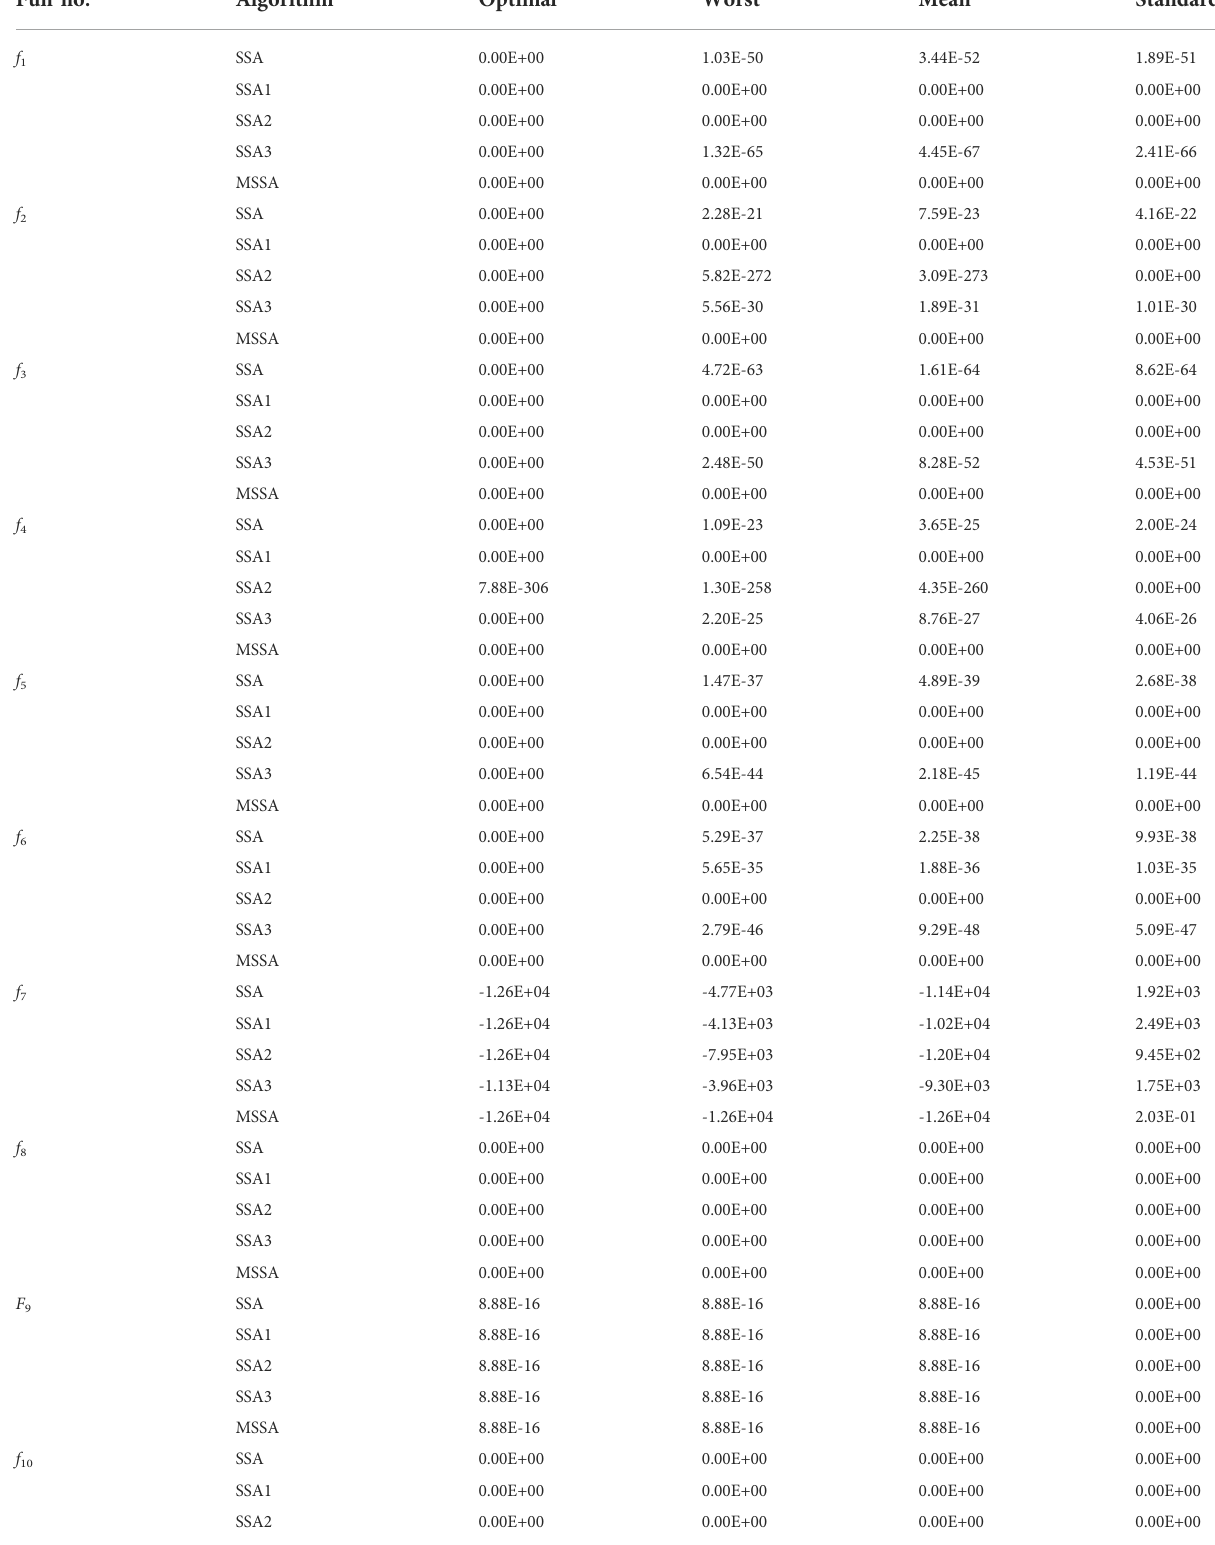
TABLE 2 Comparison of optimization results of different improvement strategies for SSA. Fun